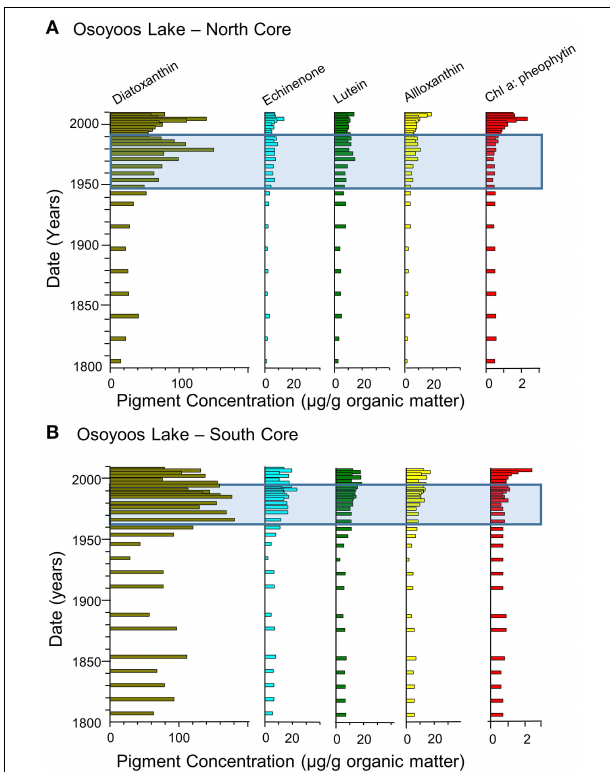
FIGURE 4 | Changes in the pigment concentrations from the dominant algal groups from the dated sediment cores from the north (A) and south (B) basins of Osoyoos Lake over the last 200 years. These pigments include: diatoxanthin (predominantly diatoms), echinenone (cyanobacteria), lutein (green algae), and alloxanthin (cryptophytes). The ratio of chlorophyll a : pheophytin is a widely used index of preservation, often an indicator of incomplete post-depositional processes. The blue rectangle represents the zone from which pigment concentrations begin to increase to c. 1990, when the dominant pigment, diatoxanthin, begins to decline, consistent with measured decreases of total phosphorus in modern water chemistry